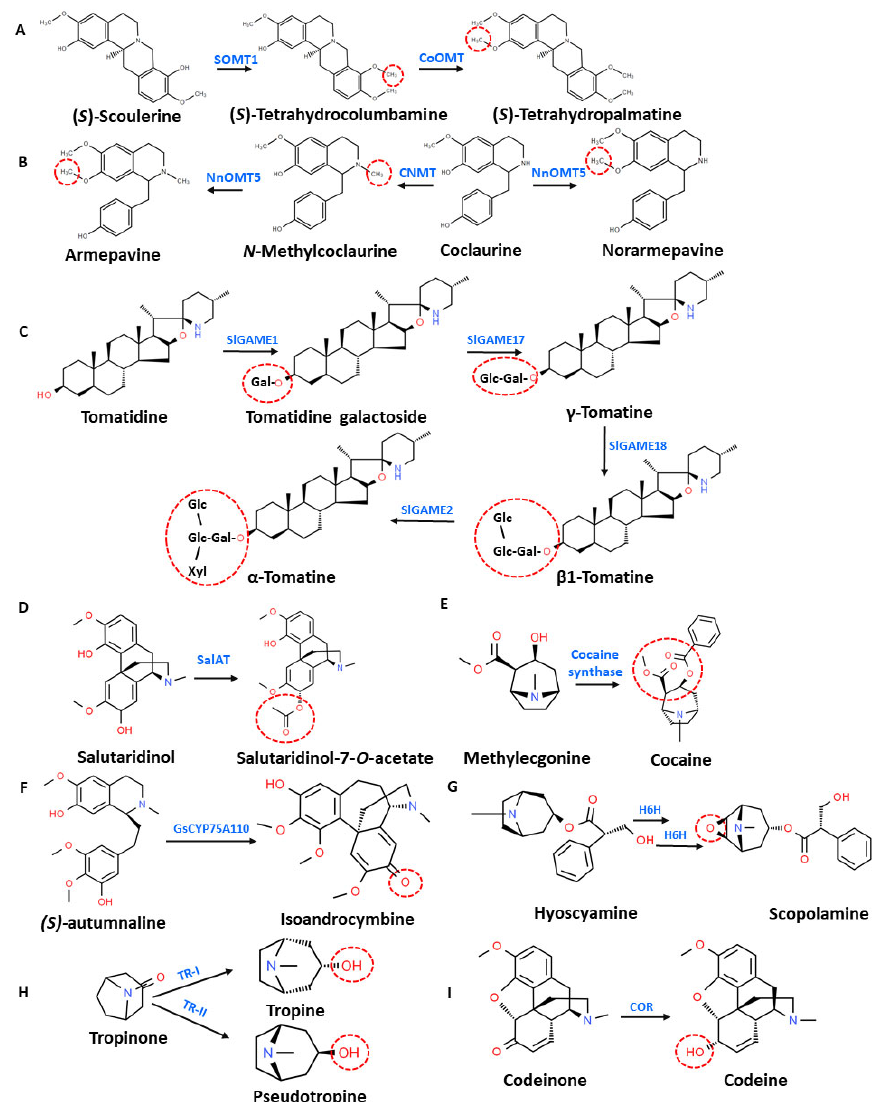
Figure 3. Examples of chemical reactions taking place in alkaloid biosynthesis in plants. Enzymes catalyzing various reactions are indicated in blue. Red dotted circles indicate the addition of functional entities at the respective positions. ( A ) Methylation reactions in the biosynthesis of alkaloids in genus Corydalis, SoOMT1 : scoulerine 9 ‐ O ‐ methyltransferase,